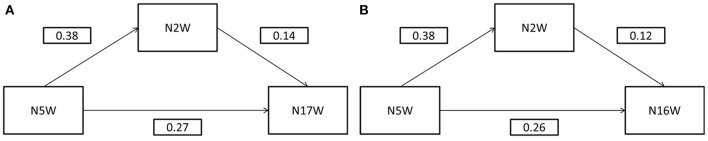
(A) Mediation Model for N17W. (B) Mediation Model for N16W. N2W, Talk with someone about worries and fears; N5W, clarify open aspects (N5W); N16W, forgive someone; N17W, be forgiven; scores are β values.